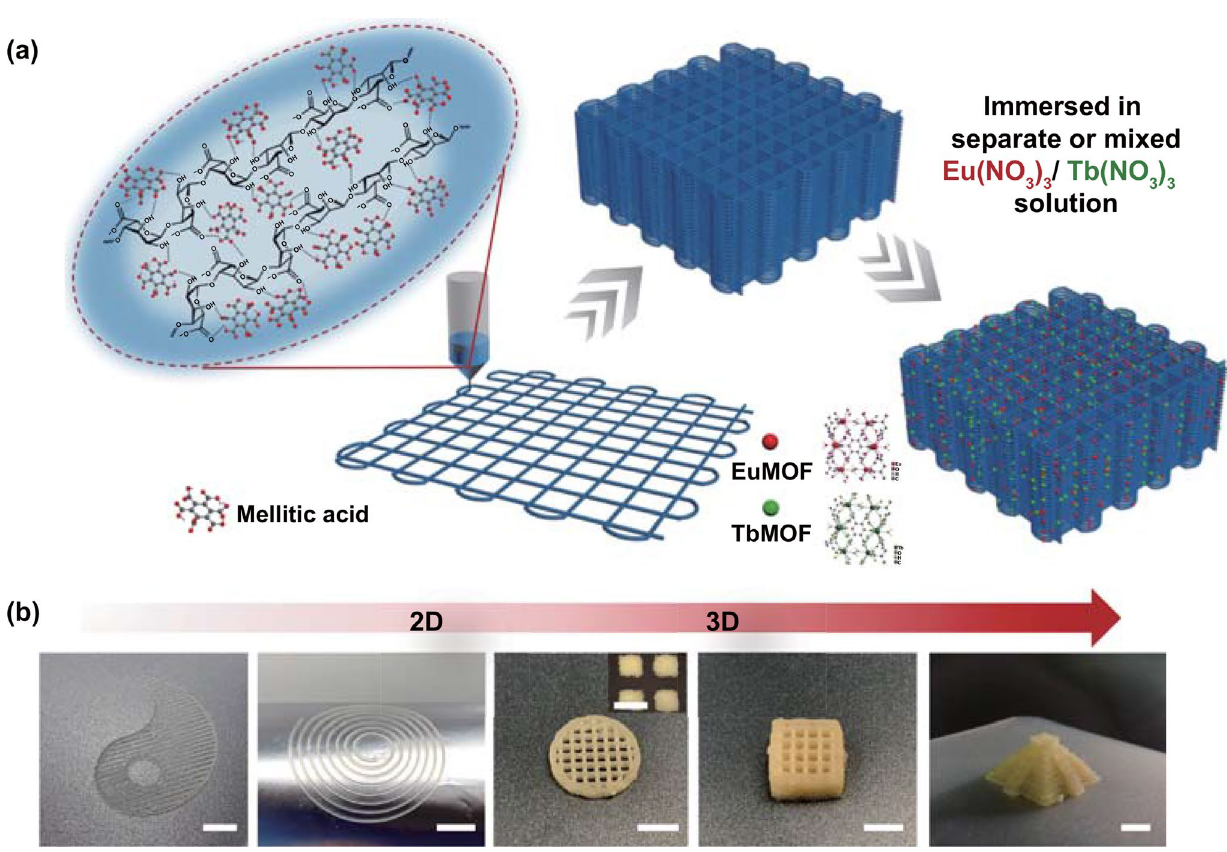
Fig. 1 Mechanism and illustration of controlled assembly in 3D printing. a Schematic diagram of the 3D printing process and post-printing treatment for in situ growth of LnMOFs within the 3D-printed constructs. b Digital photos of the 3D-printed patterns and scaffolds (Scale bars: 5 mm). Inset is the enlarged image representing the pores of the printed structure with sub-millimeter resolution (Scale bar: 1